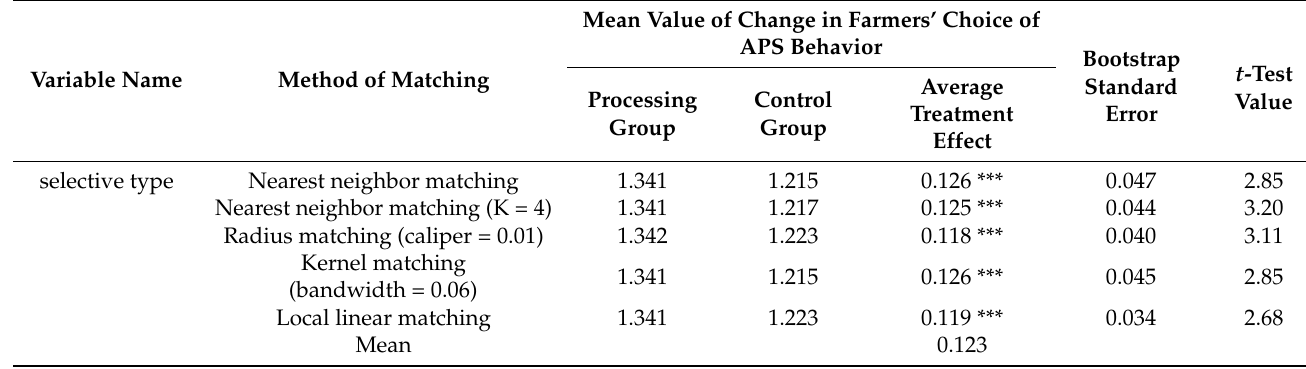
Table 10. Robustness test considering self-selection bias (PSM).